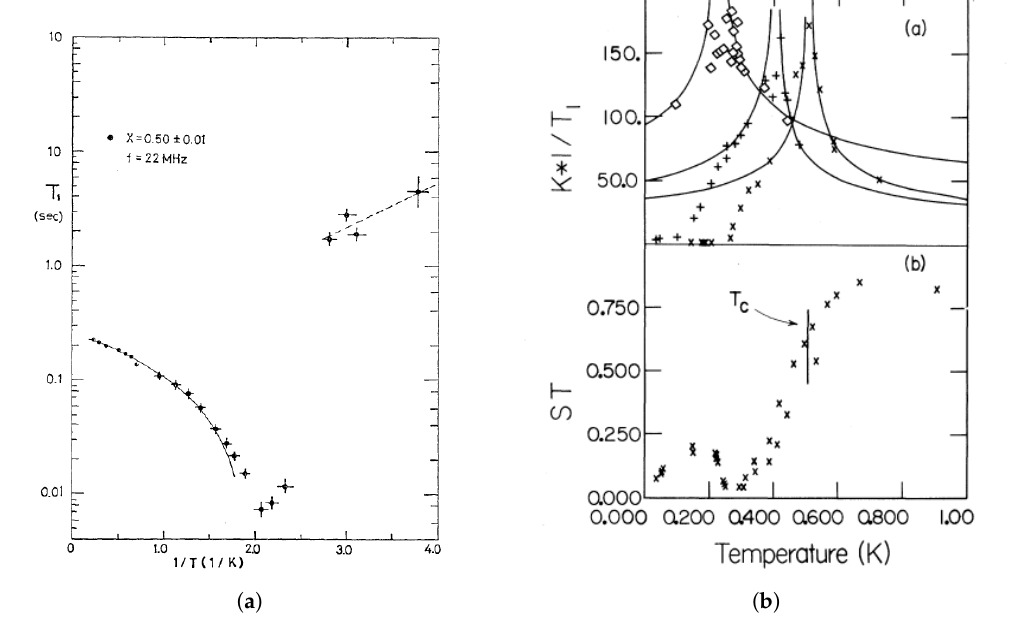
Figure 2. Observed variation of the nuclear spin-lattice relaxation times of solid ortho-para hydrogen mixtures showing the sharp change in the temperature dependence attributed to the onset of quadrupolar glass formation. Figure 3b also shows the variation of the echo amplitudes S , indicating changes in the static order parameters below 0.55 K. In contrast to the variation of T 1 , S evolves smoothly with temperature. ( a ) Temperature dependence of relaxation times for 50% ortho H 2 in solid ortho-para H 2 mixtures. Reproduced with permission from Figure 6 of Ishimoto et al. [25]. ( b ) Temperature dependence of relaxation times for 33% (diamonds), 40% (pluses) and 50% (crosses) ortho H 2 . Reproduced with permission from [26]. Copyright American Physical Society,